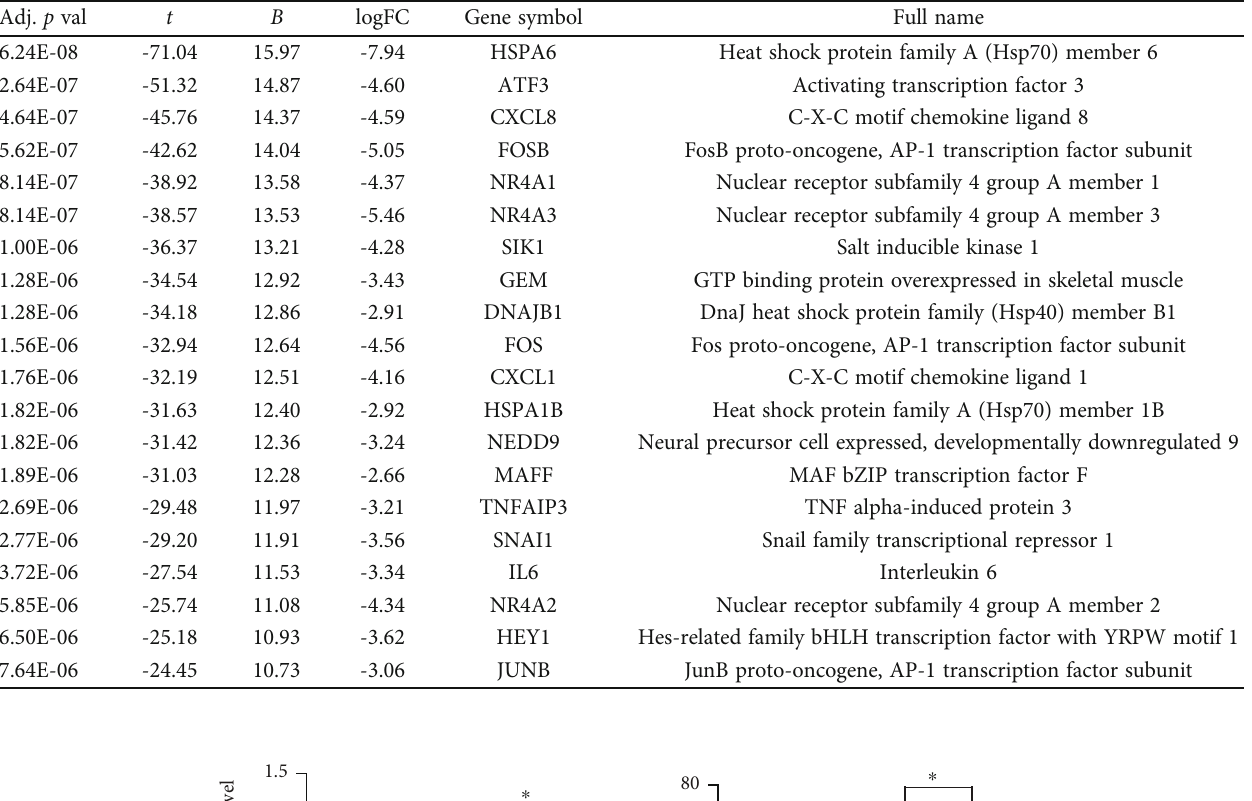
Table 1: There were top 20 di ff erentially expressed genes (|log2 (FC)| > 2.5 and adjusted p < 0 : 05 ) between BEAS-2B cells stimulated with UV-inactivated RSV and RSV-infected BEAS-2B cells.